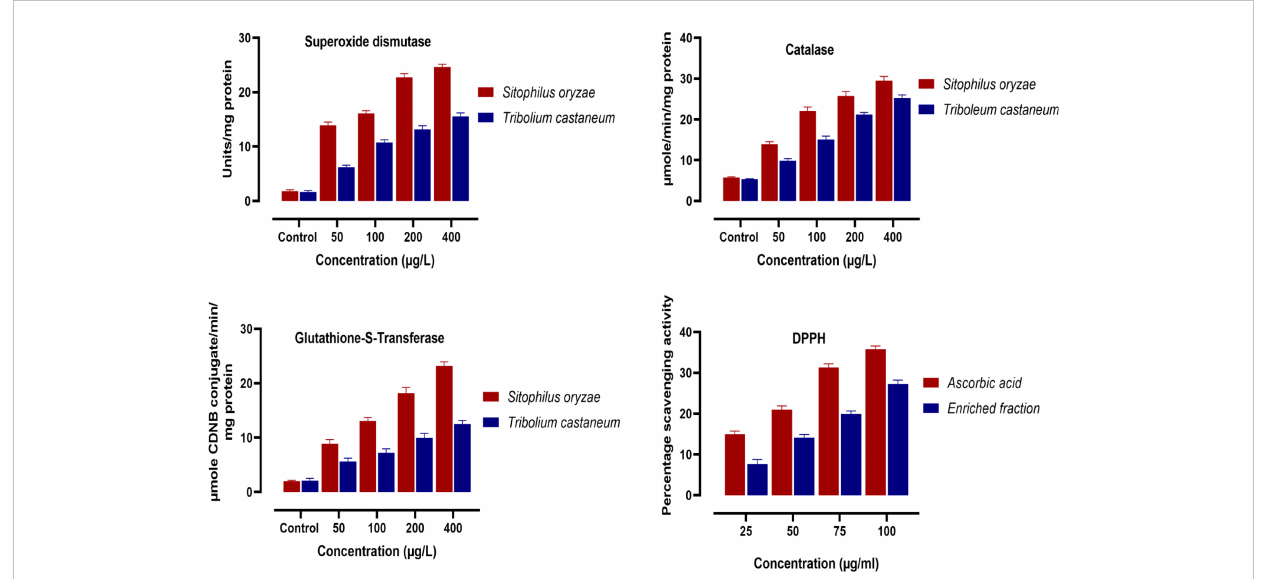
FIGURE 4 Effect of different concentrations of the enrich fraction eluted from ethyl acetate extract of D. indica leaves on the activity of enzymatic antioxidants in S. oryzae , and T. castaneum .